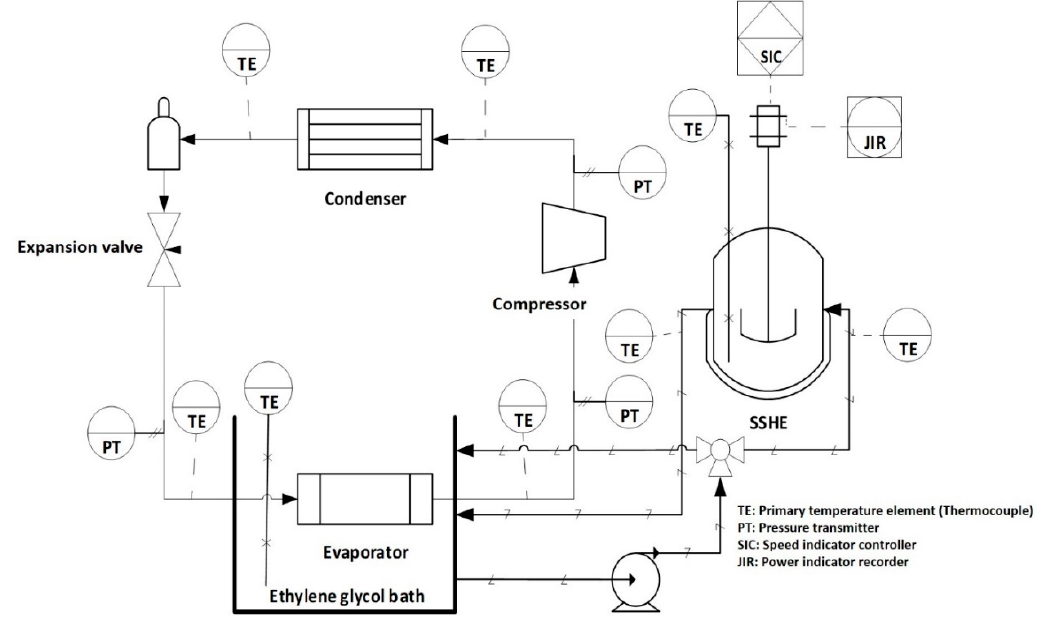
Figure 1. Scheme of the SSHE coupled to a cooling system.